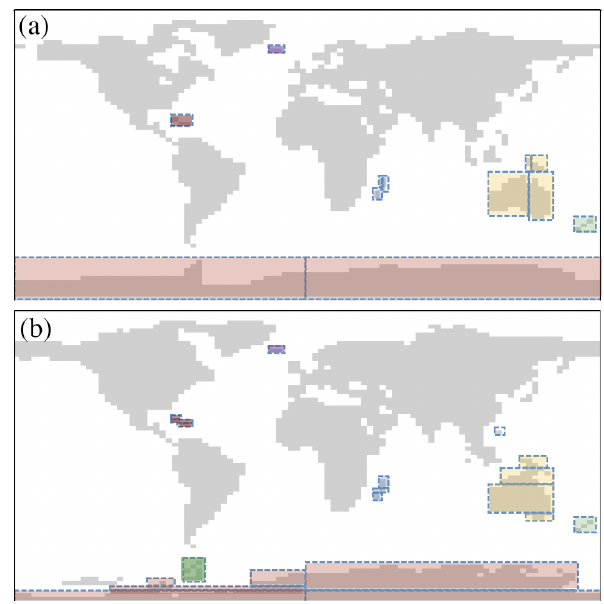
Figure 1. LSM and barotropic streamfunction island configuration for the (a) pre-industrial and (b)